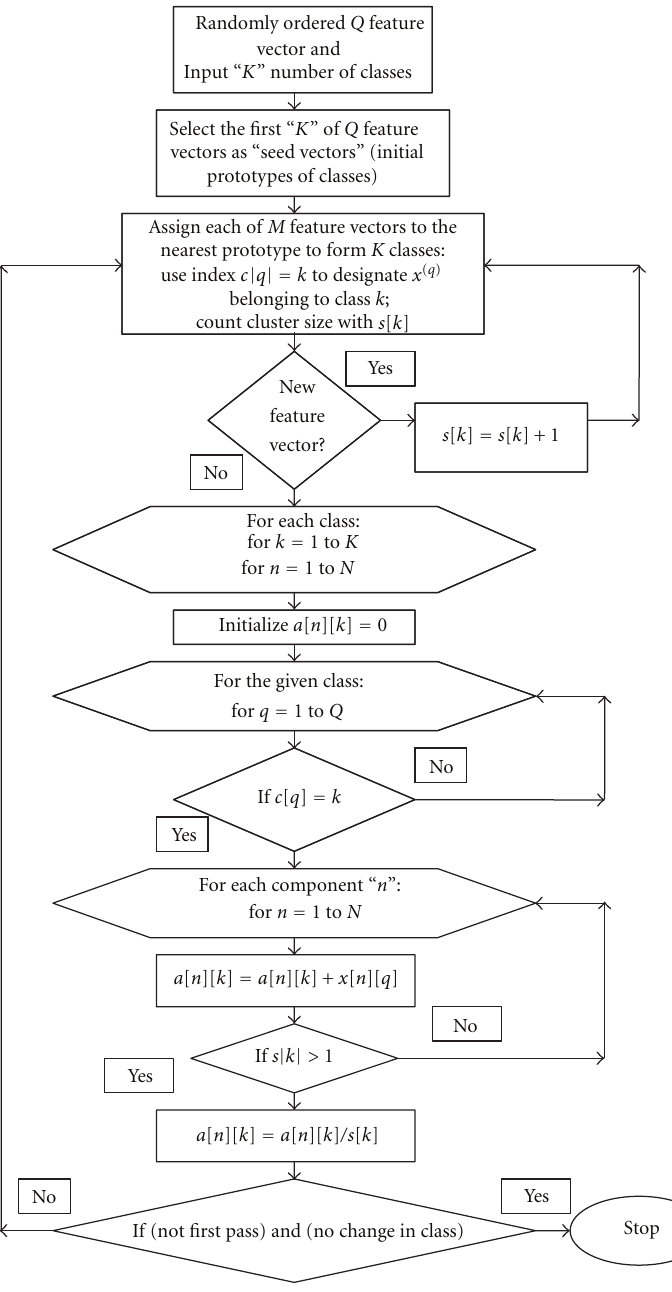
Figure 3: Flow chart of K -means clustering